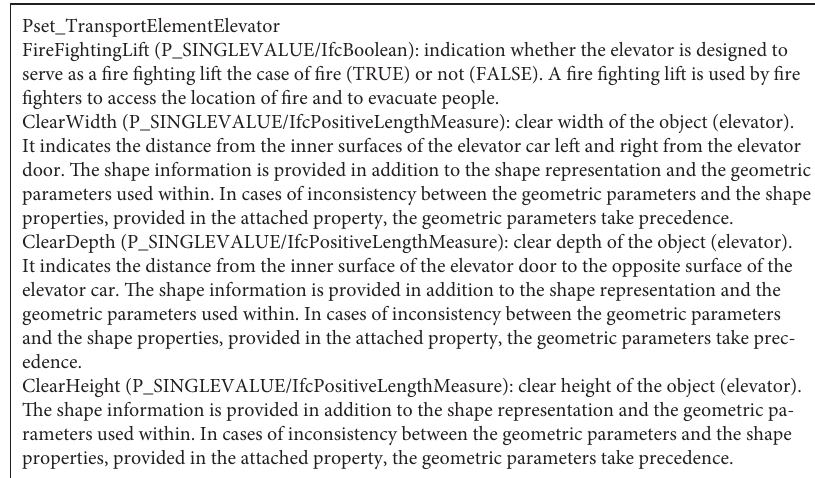
Figure 4: The properties of elevator in IFC